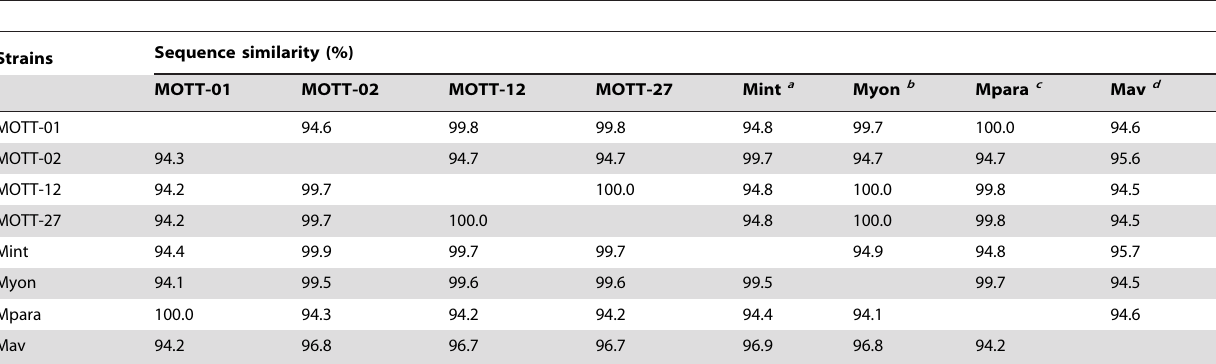
Table 1. Full rpoB gene sequence (3447 and 3450 bp; right upper side) and concatenated sequence [16S rRNA (1383 or 1395 bp) +